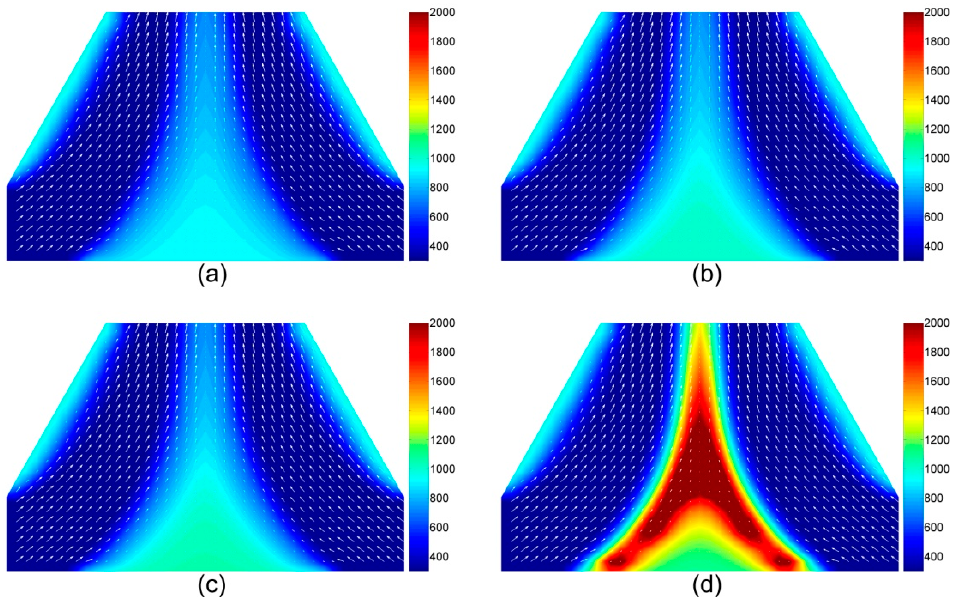
Figure 9. The temperatures and velocities of the volatile species in the gaseous phase for a 10 mm thickness PC plaque under 50 kW/m 2 heat flux at: ( a ) 200 s; ( b ) 400 s; ( c ) 600 s; and ( d ) 1000 s.